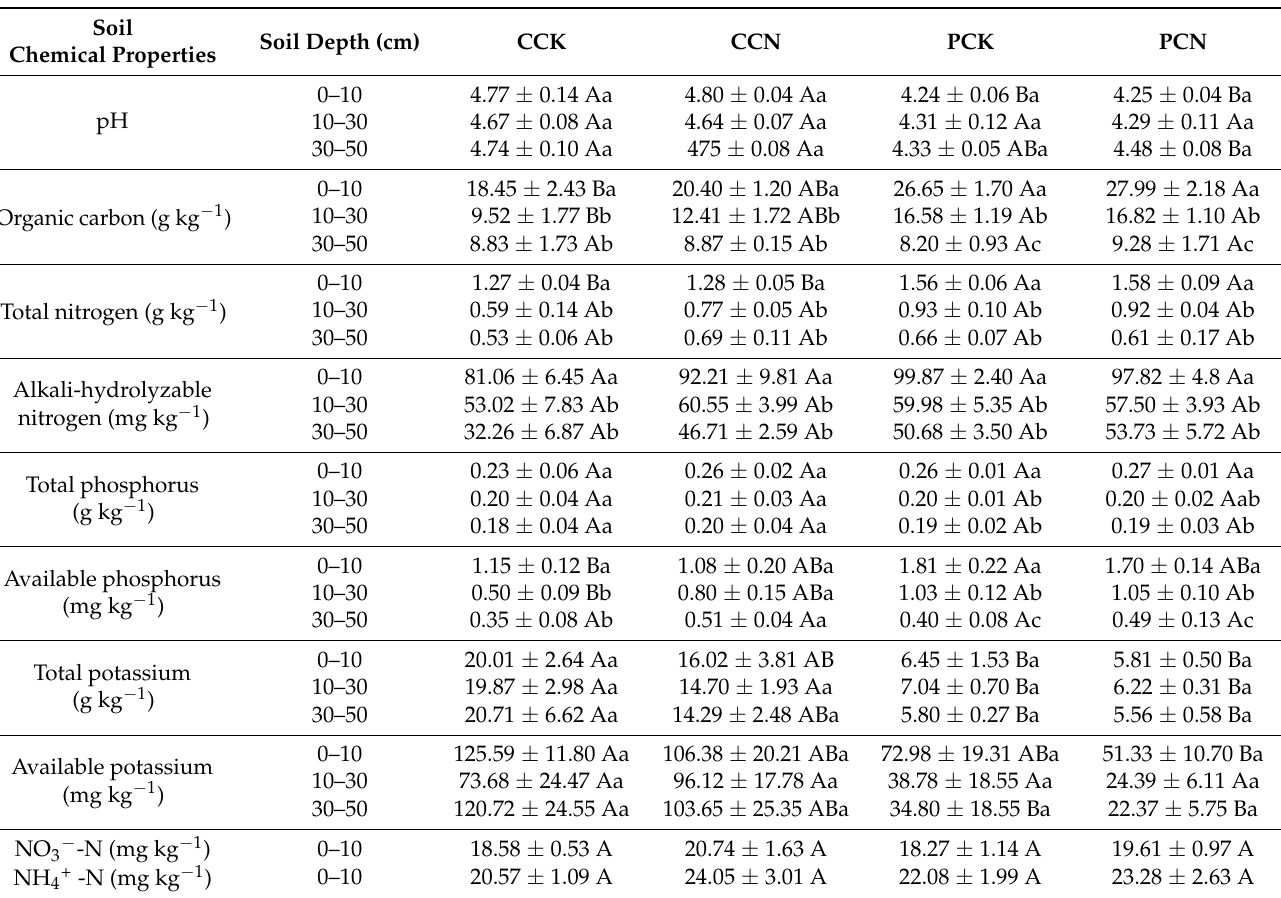
Table 2. Effects of close-to-nature transformation on soil chemical properties of Pinus—Cuninghamia plantations. Mean ±